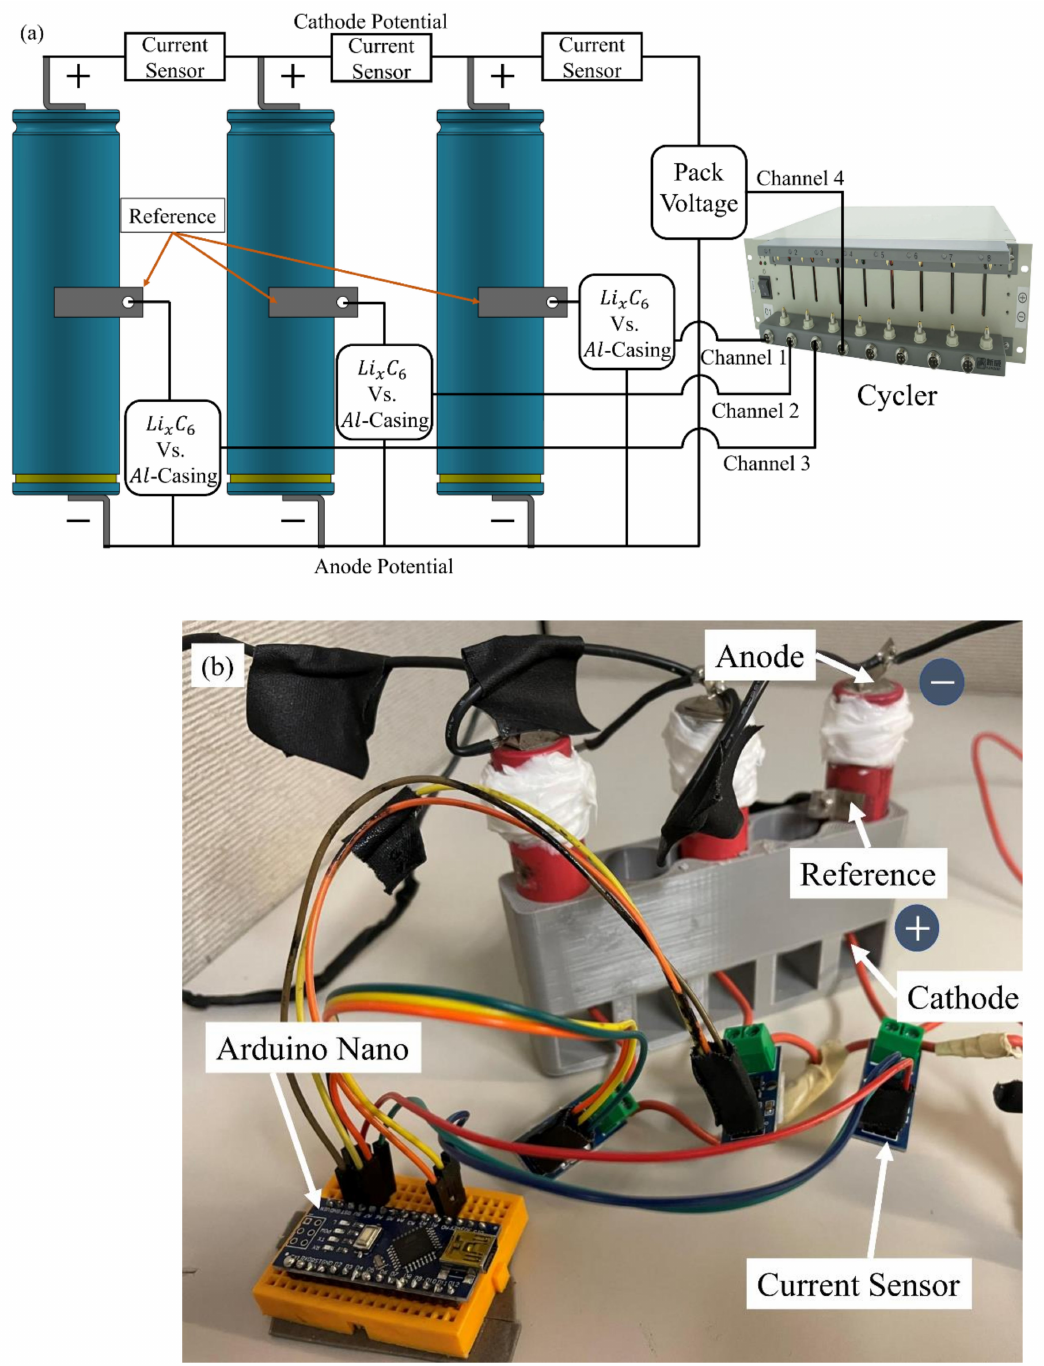
Figure 3. Experimental setup of three-electrode battery pack. ( a ) writing diagram. ( b ) experimental